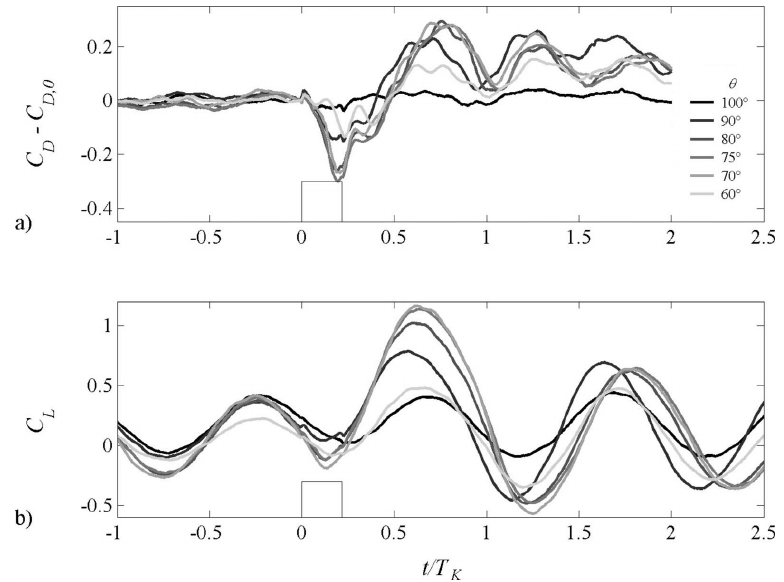
FIG. 14. Effect of plasma location. (cid:1) a (cid:2) Phase-averaged drag coefficient; (cid:1) b (cid:2) phase-averaged lift coefficient after a single plasma pulse of duration Figure 11. Time evolution of phase-averaged drag coefficient C D ( a ) and lift coefficient C L ( b ) acting on (cid:8) / T (cid:1) E =7.4 kV (cid:2) at t / T K =0.22, force coefficient C plasma =0.45 % K =0.25. p.-p. 0 a circular cylinder subjected to short-duration excitation from a single DBD-plasma actuator mounted at different azimuthal locations on the cylinder surface; Re D = 1.5 × 10 4 , C F = 0.45%. C D ,0 , and T K , respectively are the drag coefficient and the period of vortex shedding of the uncontrolled flow. The pulse duration (0.22 T K ) is indicated on the figure by a rectangle. Reprinted from the work by the authors of [74] with the permission of AIP